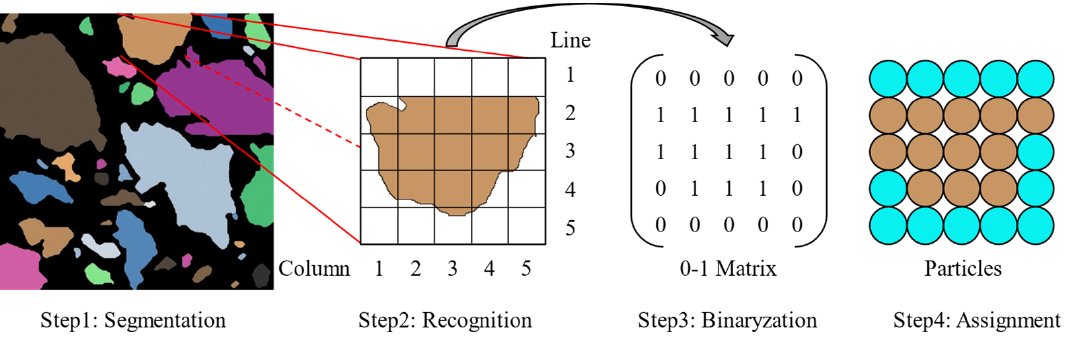
Figure 12. Transformation of the aggregate from images into discrete element models. At present, the general and technically mature discrete element software includes PFC, a commercial granular flow software developed by Itasca; MatDEM, a matrix discrete element software independently developed by Nanjing University; Yade, a large open- source discrete element software, and